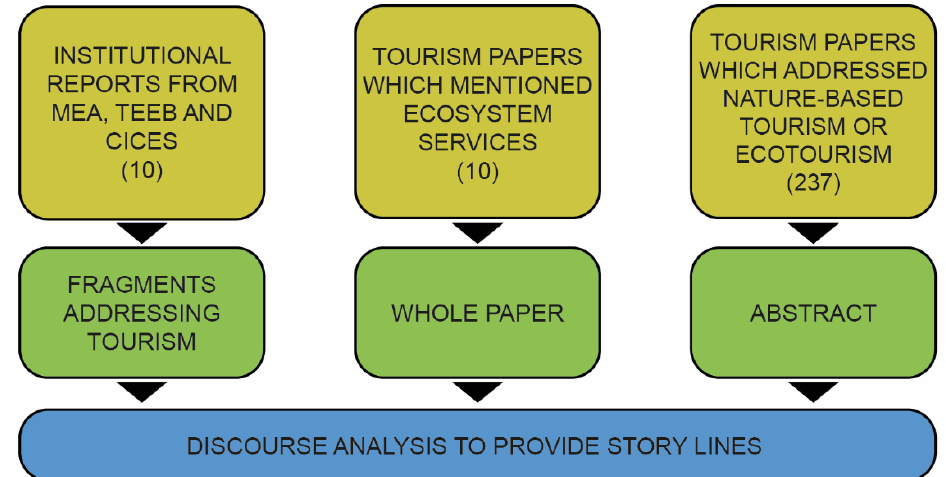
Figure 1. Summary of samples and methods.